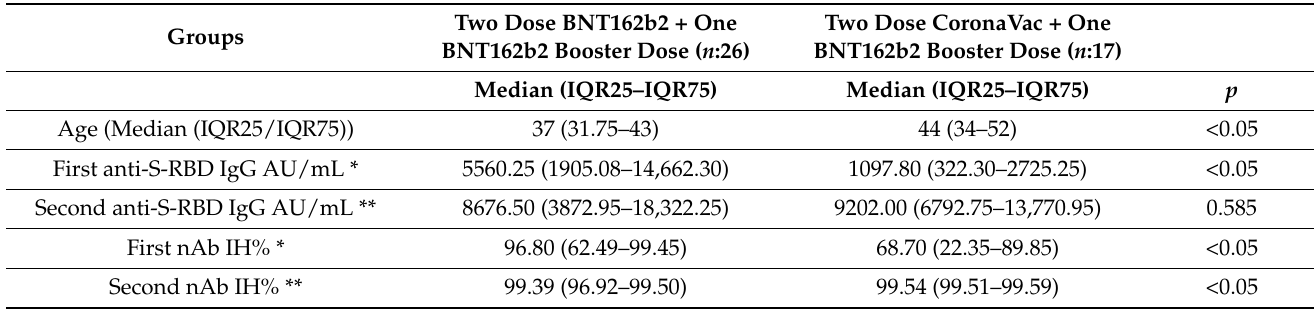
Table 4. Distribution of antibody results in subjects with a history of COVID-19 who received a BNT162b2 booster dose after two doses of the BNT162b2 or two doses of the CoronaVac